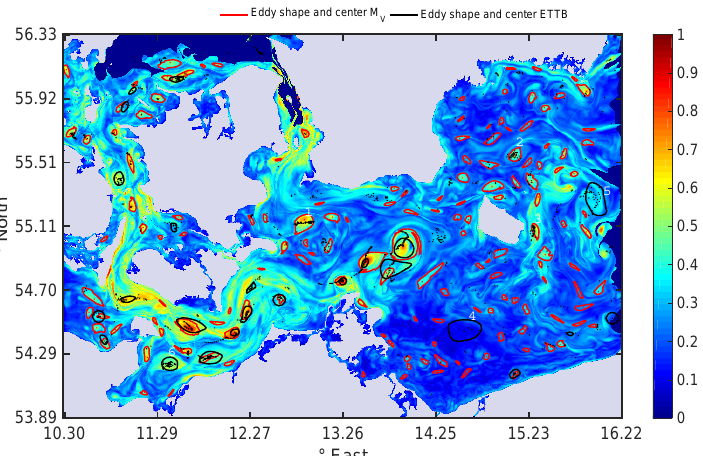
Figure 11. M V for the western Baltic Sea for 11 May 2009 at 01:00LT with τ = 36h normalized to the maximum value of M V . The red lines are the eddy boundaries, and red dots the eddy cores detected with the method based on M V . The black lines are the eddy boundaries detected with the ETTB by Nencioli et al. (2010) on 11 May 2009 at 01:00LT. The black dots are the eddy cores detected with the ETTB by Nencioli et al. (2010) within the time interval of 11 May 2009 at 01:00LT ± 36h. The dark blue regions are areas where the trajectories have left the domain of interest; light grey regions indicate